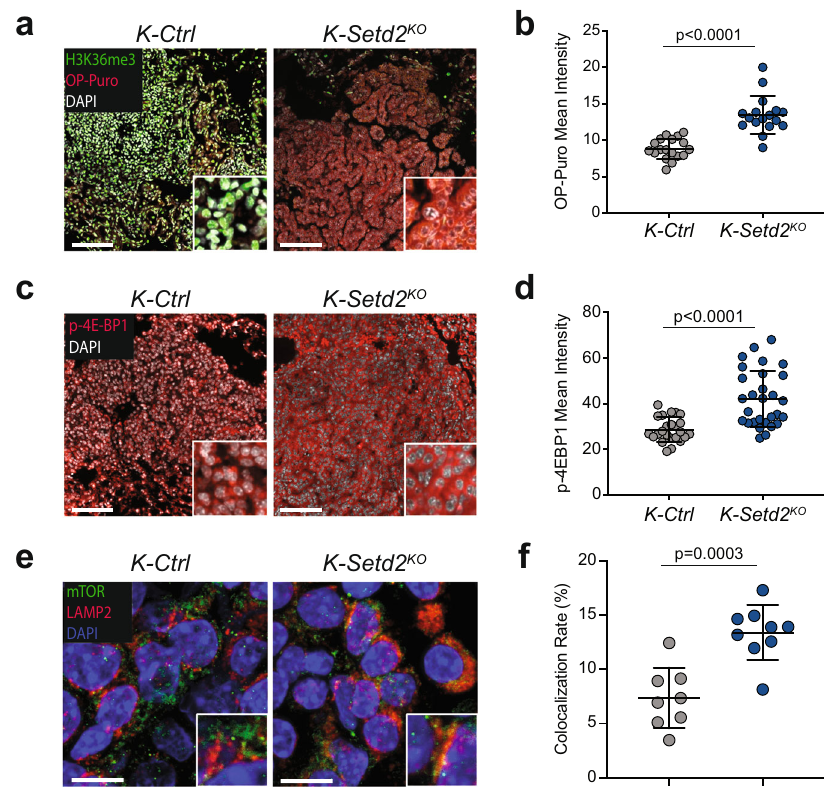
Fig. 3 SETD2-de fi cient tumors have increased protein synthesis and high mTORC1 signaling. a Representative images of o-propargyl-puromycin (OP- Puro) incorporation (red), H3K36me3 (green), and DAPI-stained nuclei (white) in K-Ctrl (left) and K-Setd2 KO (right) tumors. Scale bars = 100 μ m, insets are magni fi ed 5x. b Quanti fi cation of OP-Puro mean fl uorescence intensity in K-Ctrl and K-Setd2 KO tumors. Data represent the mean ± standard deviation. Data points represent individual tumors ( K-Ctrl : n = 18 tumors, n = 3 mice, K-Setd2 KO : n = 17 tumors, n = 3 mice). Signi fi cance determined by unpaired Student ’ s t -test. c Representative images of phosphorylated 4E-BP1(T37/46) staining (red) in K-Ctrl (left) and K - Setd2 KO (right) tumors. Nuclei are counterstained with DAPI (white). Scale bars = 100 μ m, insets are magni fi ed 5x. d Quanti fi cation of p-4E-BP1(T37/46) mean fl uorescence intensity in K-Ctrl and K-Setd2 KO tumors. Data represent the mean ± standard deviation. Data points represent individual tumors ( K-Ctrl : n = 24 tumors, n = 3 mice, K-Setd2 KO : n = 29 tumors, n = 3 mice). Signi fi cance determined by unpaired Student ’ s t -test. e Representative images of co-immuno fl uorescence of mTOR (green) and LAMP2 (red) indicating localization of mTOR at the lysosome (yellow) in K-Ctrl (left) and K-Setd2 KO (right) tumors. Nuclei are counterstained with DAPI (blue). Scale bars = 10 μ m, inset is magni fi ed 2X. f Quanti fi cation of the percentage of colocalization between mTOR and LAMP2 in K- Ctrl and K-Setd2 KO tumors. Data points represent individual tumors ( K-Ctrl : n = 8 tumors, n = 3 mice, K-Setd2 KO : n = 9 tumors, n = 3 mice). Signi fi cance determined by unpaired Student ’ s t were counted in ImageJ using the Cell Counter plugin 51 . For all histological analyses each data point represents an individual tumor. Flow Cytometry . Tumors were microdissected directly from the lungs of Kras LSL- G12D/ + ;Trp53 fl ox/ fl ox ; Rosa26 LSL-YFP/LSL-YFP ( KPY ) mice and individually placed in 500 μ l of tumor digestion buffer consisting of PBS containing 10 mM HEPES pH 7.4, 150 mM NaCl, 5mM KCl, 1mM MgCl 2 , and 1.8mM CaCl 2 , along with freshly added Collagenase 4 (Worthington 100 mg/ml solution, 20 μ l per ml of digestion buffer) and DNase I (Roche 10 mg/ml solution, 4 μ l per ml of digestion buffer). Tumors were manually disassociated using scissors, and then placed in a 4°C shaker for 1hour at 250rpm. Digested tumors were then fi ltered into strainer-cap fl ow tubes (Corning, 352235) containing 1ml of horse serum (Thermo Fisher, 16050122) to quench the digestion reaction. Cells were spun down at 200 g for 5minutes with the cap in place to obtain all cells. The supernatant was aspirated, cells were washed once with PBS and then resuspended with a given mitochondrial dye to stain for 30minutes at 37 °C. To quantify mitochondrial volume, cells were incubated with 50 nM MitoTracker Deep Red FM (Thermo Fisher, M22426), combined with 50 μ M of CCCP (Thermo Fisher, M34151) to eliminate con- founding effects of mitochondrial membrane potential differences. To quantify mitochondrial membrane potential cells were incubated with 20 nM MitoProbe DiIC1(5) (Thermo Fisher, M34151). To quantify mitochondrial oxidative potential cells were incubated with 100 nM MitoTracker Red CM-H 2 XRos (Thermo Fisher, M7513). To quantify mitochondrial ROS cells were incubated with 5 μ M MitoSOX Red (Thermo Fisher, M36008). After 30 minutes of staining, cells were washed twice with PBS and then resuspended in 100 μ l of staining solution of FACS buffer